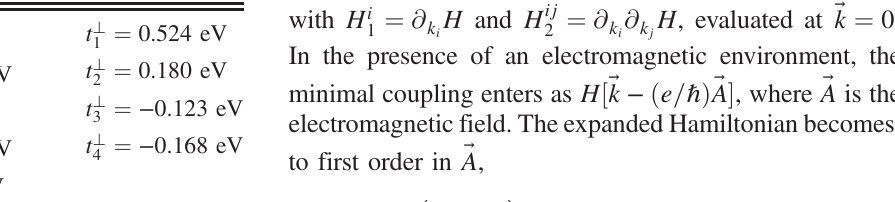
TABLE II. Values of the BP hopping parameters up to a distance of 5.49 Å., obtained in Ref. [35] from a fit to GW-LDA results.